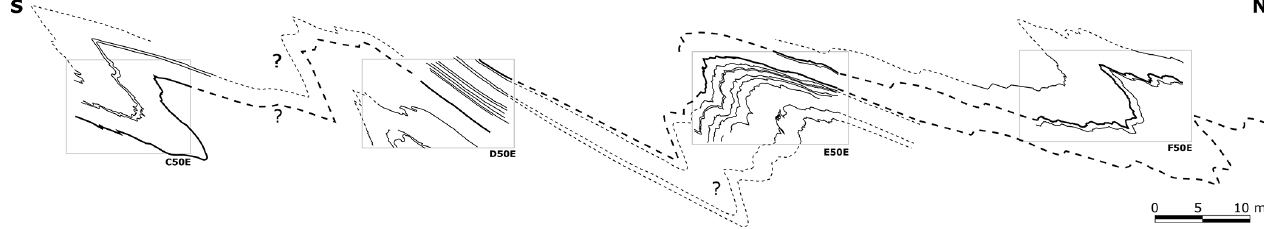
Figure 6. Cross section across the mine along the eastern side of pillar line 50 (see Fig. 2 for overview). Rectangular boxes illustrate the position of pillars. Dashed lines indicate correlations between pillars based on layer morphology and observations on the ceiling and floor as well as the other sides of the pillars.